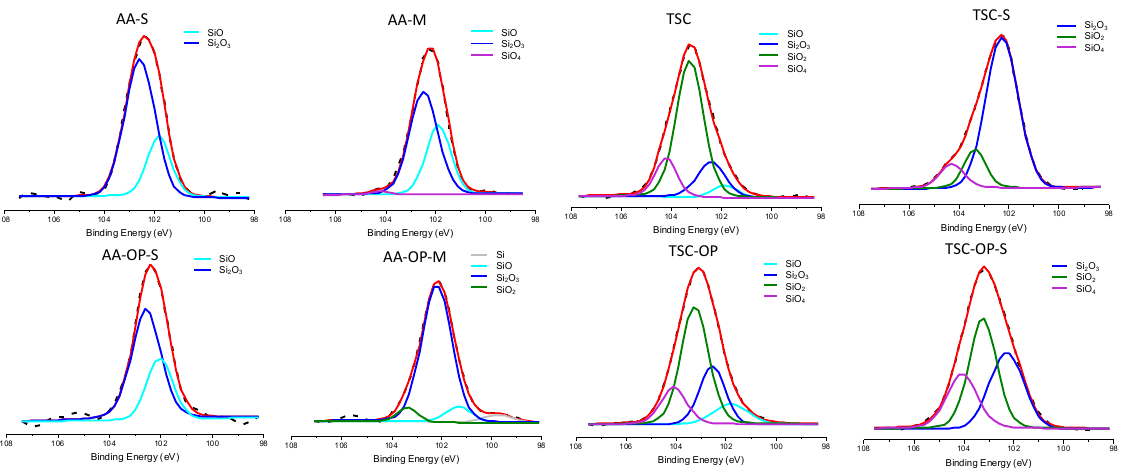
Figure 6. Deconvolution of the Si 2p spectra in the experimental groups.